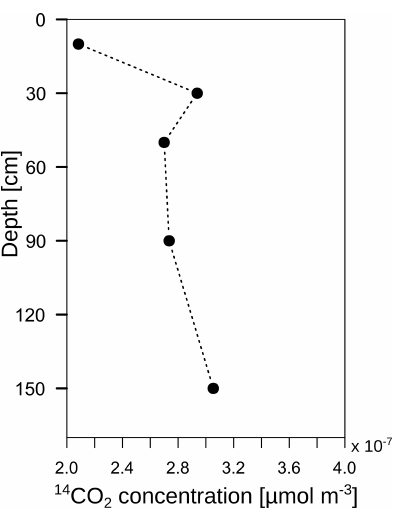
Figure 13. Soil air 14 CO 2 concentration in OB1 from Decem- ber